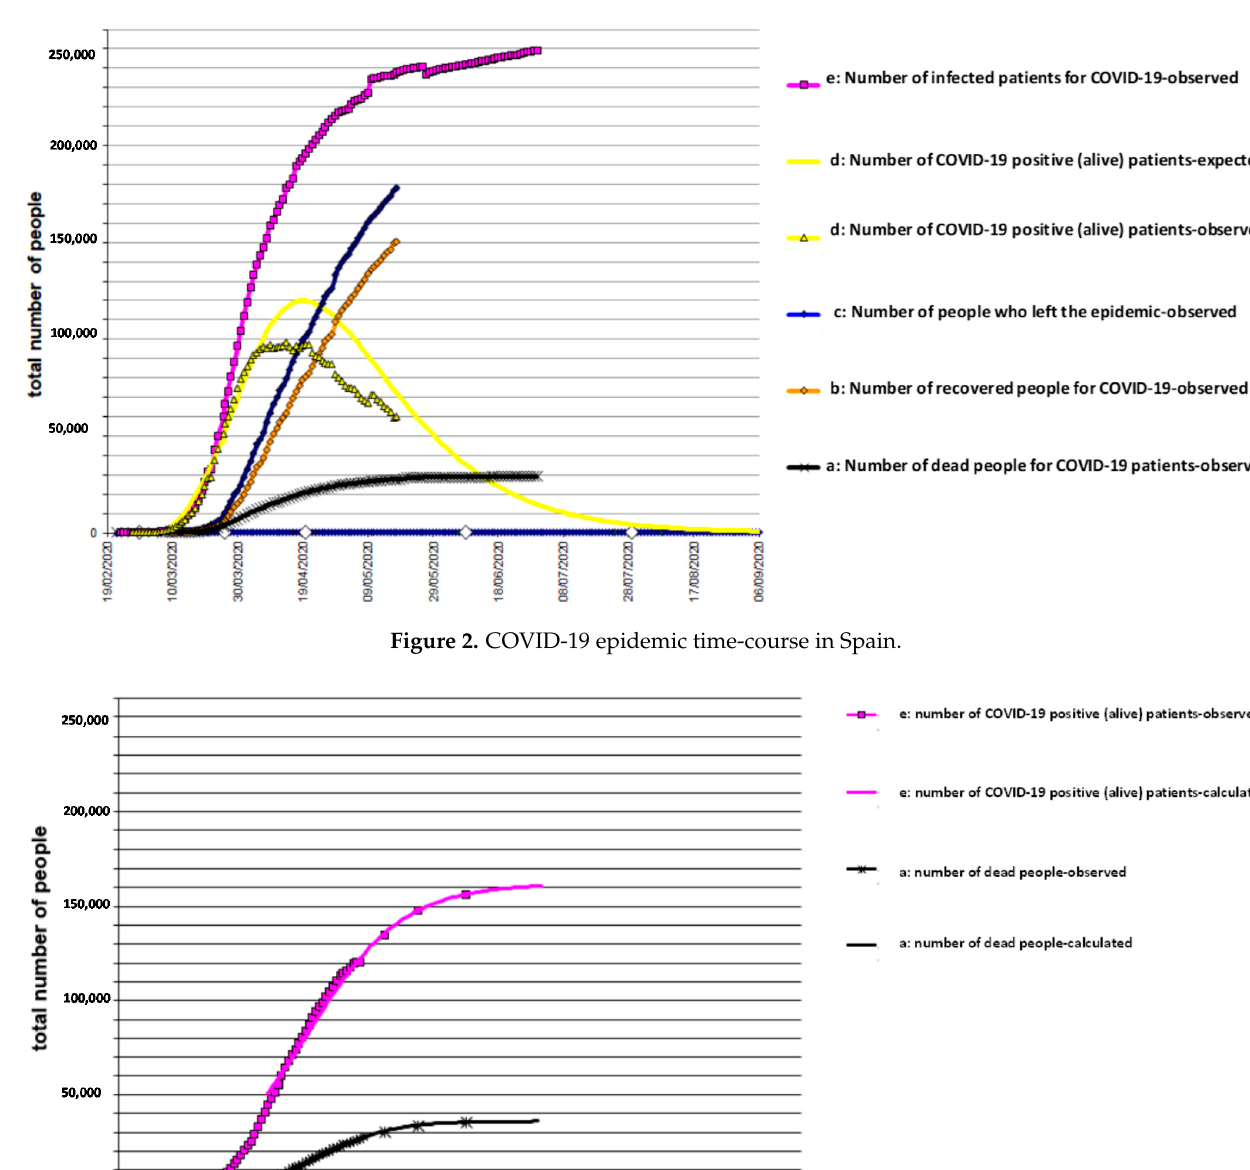
Figure 1. COVID-19 epidemic time-course in Italy.